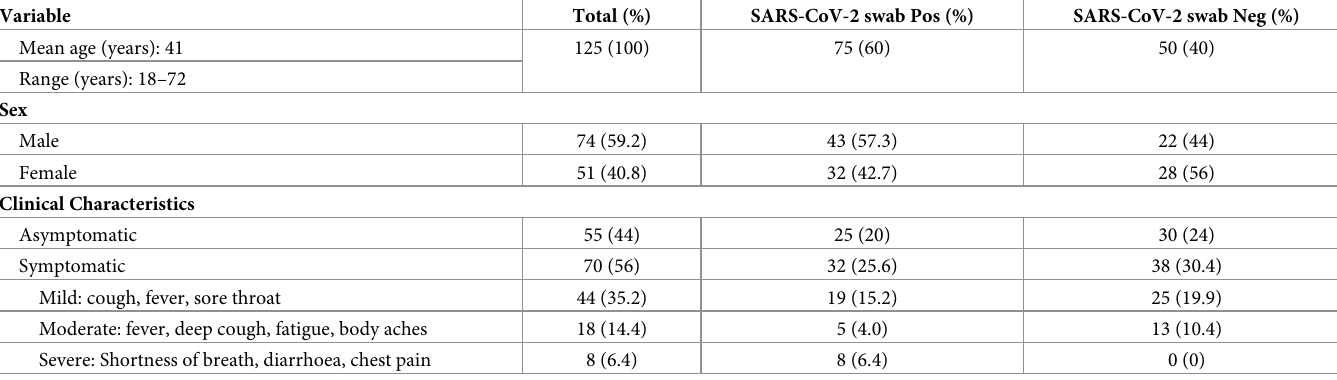
The symptoms reported were categorised as mild (consisting of cough or fever or sore throat only), moderate (cough and/or fever and/or sore throat) and severe (shortness of breath, diar- rhoea, chest pain with the other symptoms). Symptomatic mild, moderate and severe cases were 44 (35.2%), 18 (14.4%) and 8 (6.4%) respectively. Of the 75 persons positive by swab, only 32 (25.6%) had symptoms. The six persons positive by plasma all had mild symptoms. Those who were asymptomatic, negative by plasma but positive by swab were 25 (20%). Clinical pre- sentations of the individuals that reported for COVID-19 testing are shown in Table 3. Table 3. Clinical presentation of individuals reporting for the SARS-CoV-2 assay.